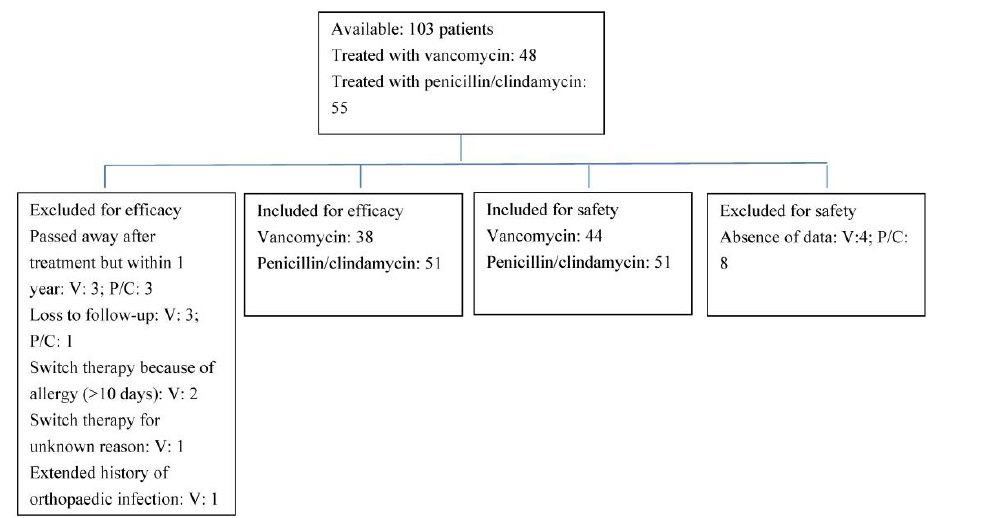
Fig 1. Inclusion. V = vancomycin; P/C =